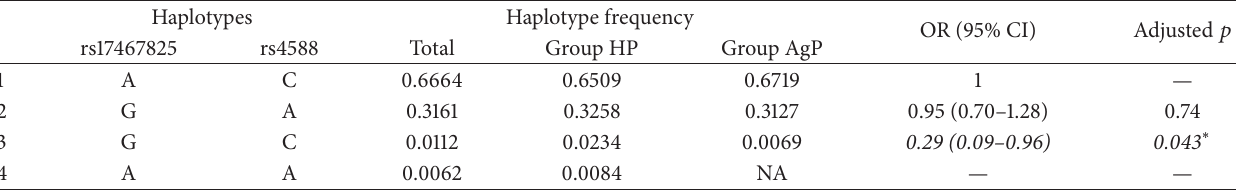
Table 3: Haplotype analysis of GC rs17467825, rs4588, and rs7041 polymorphisms and their association with generalized aggressive periodontitis.